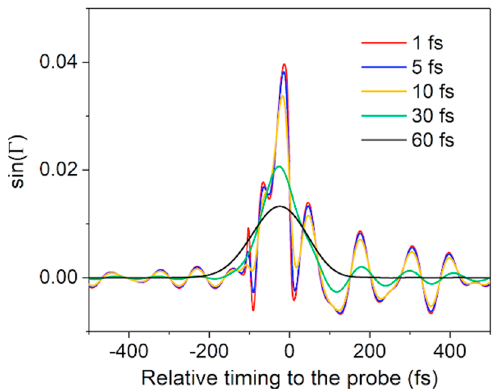
Figure 4. Numerical calculation of the EO signals with balanced detection from a 50 µ m GaP crystal. In the picture, the signal peaks shift from zero timing. It results from the difference of THz phase velocity and probe laser group velocity (phase mismatch). Distance between detection point to electron path is r 0 = 1.5 mm .